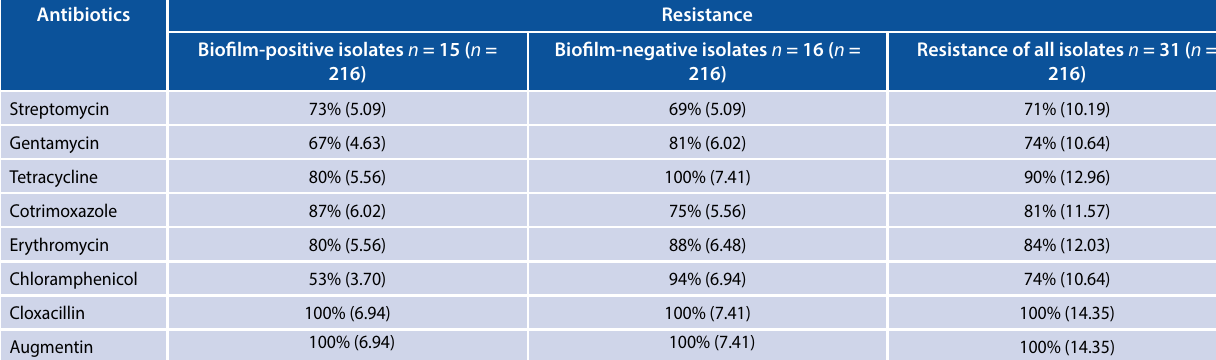
Table 2: Results of biofilm formation of bacterial isolates from mid-stream urine, catheter-stream urine and catheter tips using the tissue culture plate (TCP) and Congo red agar (CRA) methods Bacterial genera Isolates from mid-stream urine ( n = Isolates from catheter-stream urine Isolates from catheter tips ( n = 64) 100) ( n = 52) TCP CRA TCP CRA TCP CRA